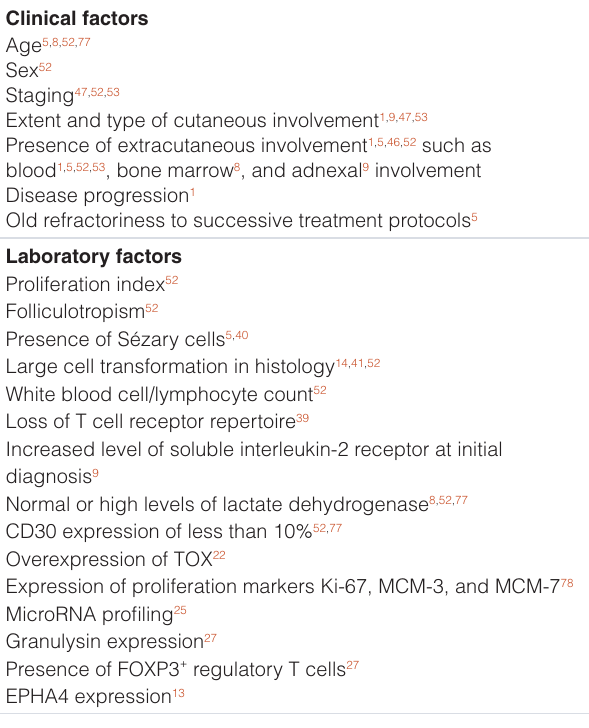
Table 3. Prognostic factors in cutaneous T cell lymphoma cases. Clinical